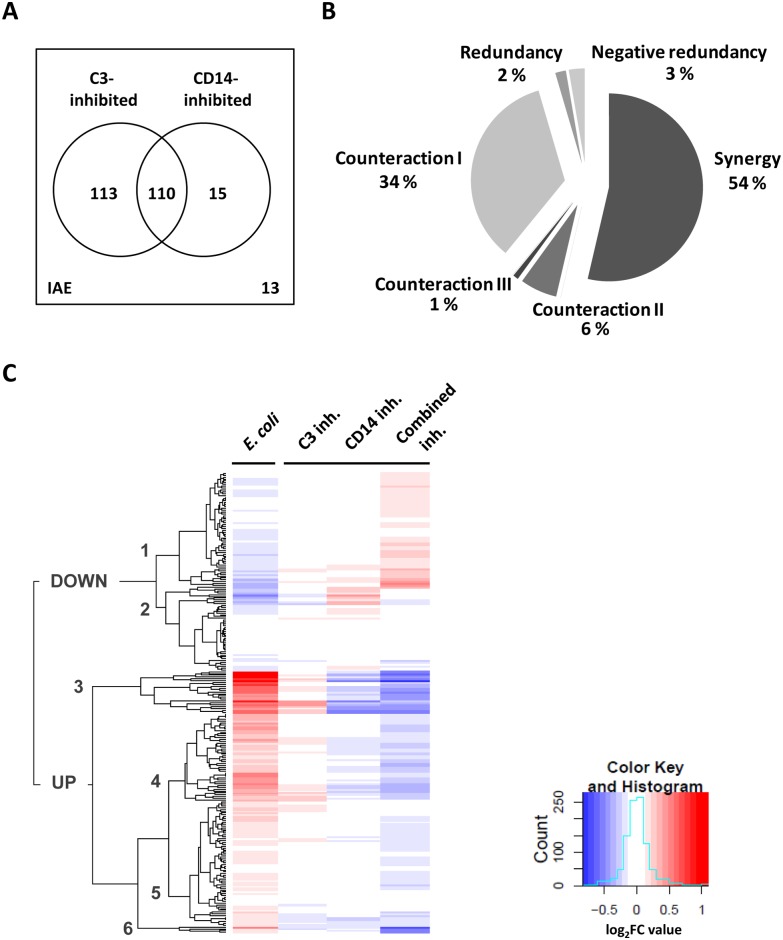
Crosstalk between CD14- and C3-dependent responses.Crosstalk between CD14 and C3 was assumed when the sum of single inhibitory effects was significantly different from the inhibitory effect of combined inhibition in ANOVA-based interaction effect analyses. This scenario was found for 251 ERGs, designated IAEs. A, The Venn diagram shows the distribution of ERGs with significant effects (ANOVA-based analysis) of single CD14 or C3 inhibition among the 251 IAE genes. Common genes are encompassed by more than one circle. The total numbers for IAEs with significant effects of C3- or CD14-inhibition were 223 and 125, respectively. IAE genes with both single and combined inhibitory effects (n = 110) were designated IAE-I. Numbers of IAEs without single inhibitory effects are indicated at the bottom right of the diagram (n = 13). B, The graph displays the distribution of IAE-I genes among six classes of crosstalk between CD14 and C3 including synergy, four types of counteraction and redundancy. The different crosstalk types were defined according to individual profiles of reversion and augmentation of the E. coli response upon single and combined inhibition using Limma-derived expression data. C, Hierarchical cluster analysis was based on Limma-derived log2FC expression values for the E. coli response of the 251 IAE genes in the absence (E. coli) and presence of the inhibitors of C3, CD14 or both. Each line contains the fold change (FC) expression data (log2FC) for a single ERG. Genes with similar responses are clustered according to the hierarchy indicated to the left. Manual examination of the heat map revealed six main clusters of related either down- (clusters 1 and 2) or up-regulated ERGs (clusters 3 to 6). The color key and histogram panel indicate total numbers of transcripts contained by the whole gene expression dataset as a function of their log2FC expression values. Negative values are displayed in blue, positive values are displayed in red.